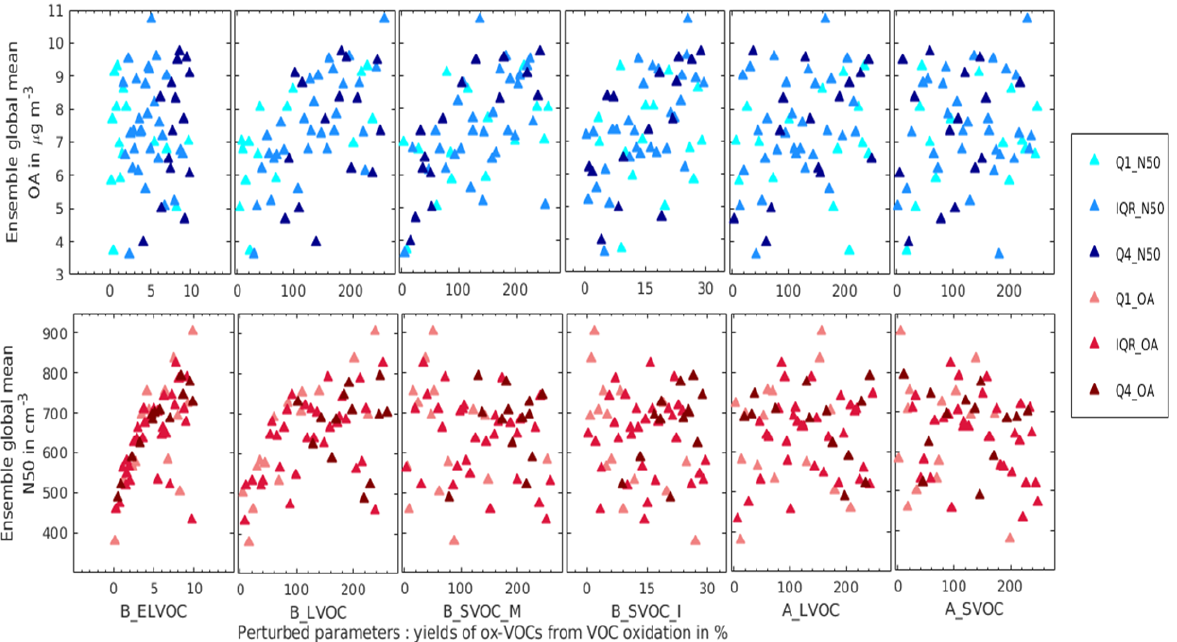
Figure 7. Global annual mean OA (top panel) and N50 (bottom panel) against the perturbed range of the six ox-VOCs for the 60 ensemble members. The three shades of blue in the top panel divide the ensemble members into three categories according to the mean N50 concen- trations: Q1_N50 for N50 values in the lower quartile, IQR_N50 for the inter-quartile range, and Q4_N50 for N50 values in the the upper quartile. The three shades of red in the bottom panel depict the same as above but for global mean OA concentrations in the